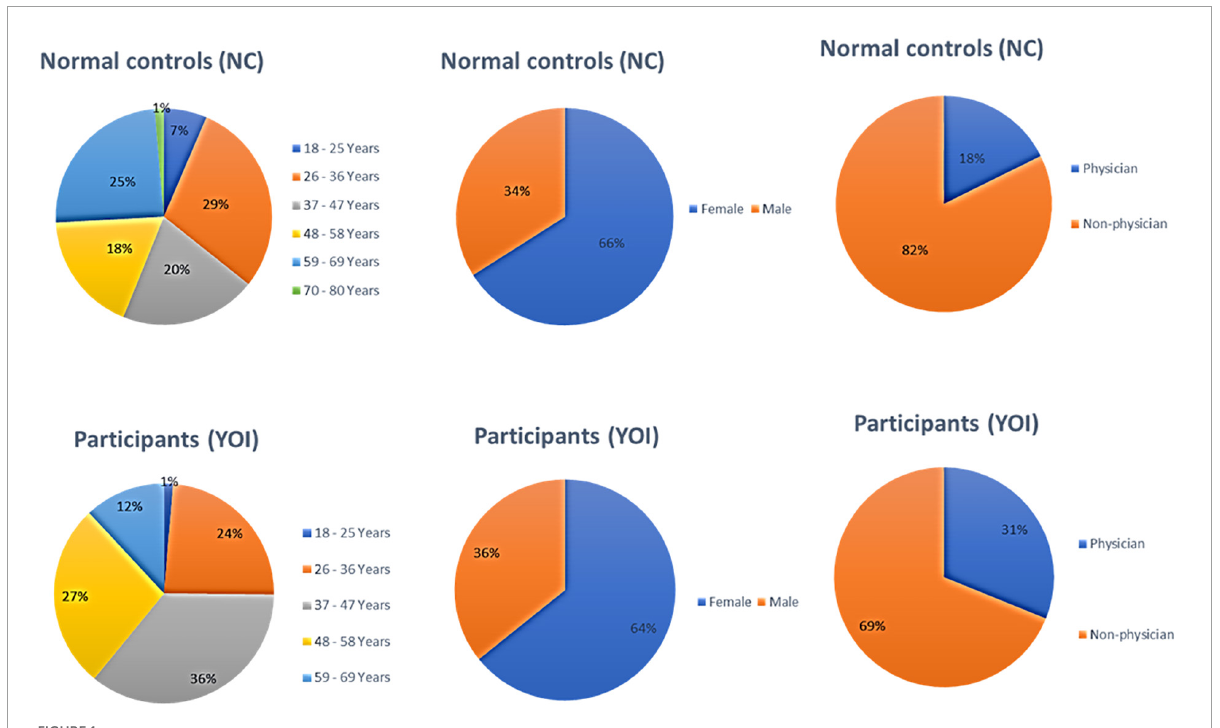
FIGURE1 Demographic characteristics of the control and participants